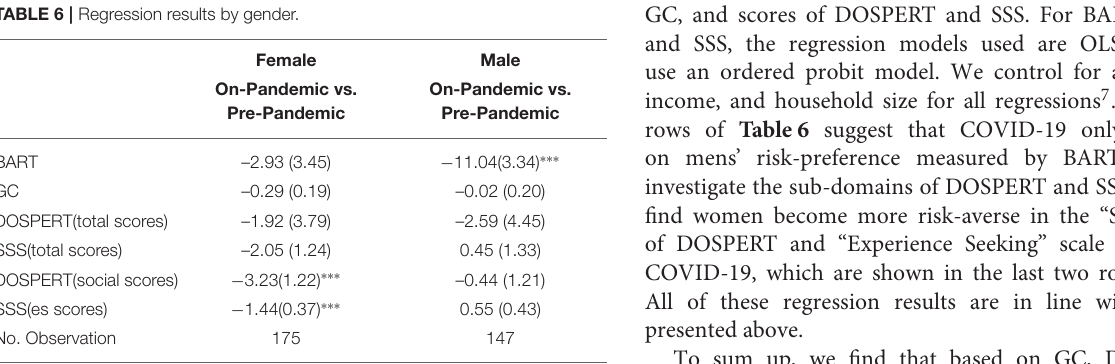
TABLE 6 | Regression results by gender.